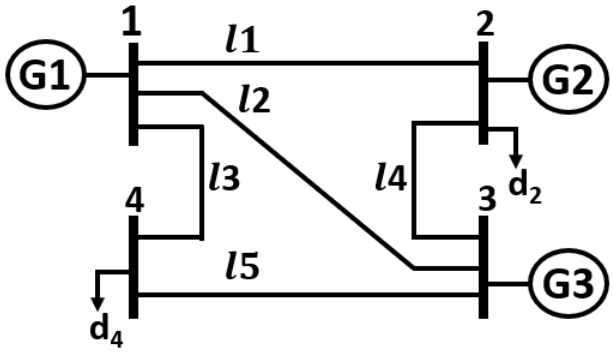
Figure 7. Three Layer Proposed SCUC Approach.